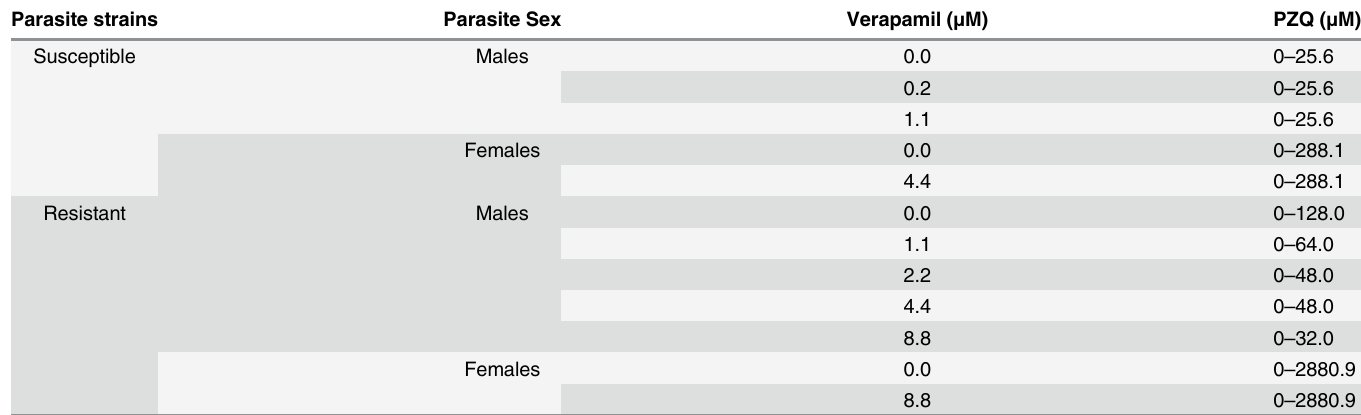
Table 1. PZQ and Verapamil concentrations used for the ex vivo PZQ susceptibility